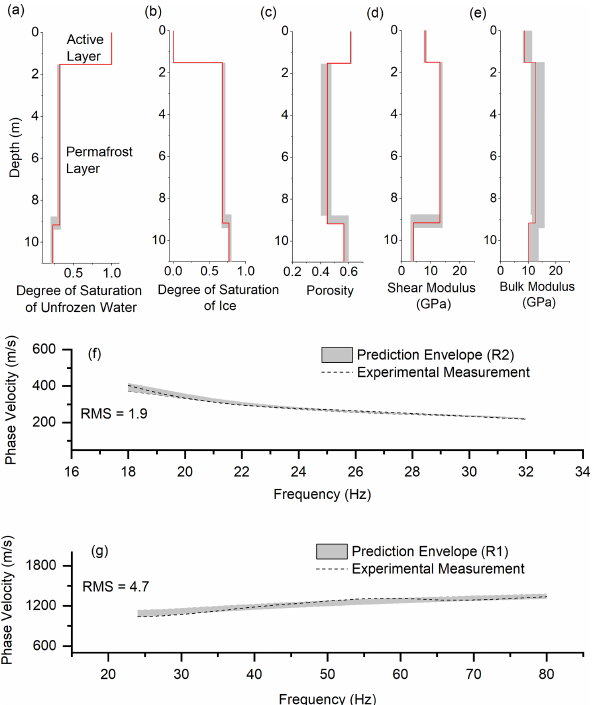
Figure 4. Surface wave inversion results for section 1: 0 to 120m. (a) Degree of saturation of unfrozen water, (b) degree of saturation of ice, (c) porosity distribution, (d) shear modulus of solid skeletal frame, (e) bulk modulus of solid skeletal frame, (f) experimental and numerical dispersion curves for the R2 wave, and (g) experimental and numerical dispersion curves for the R1